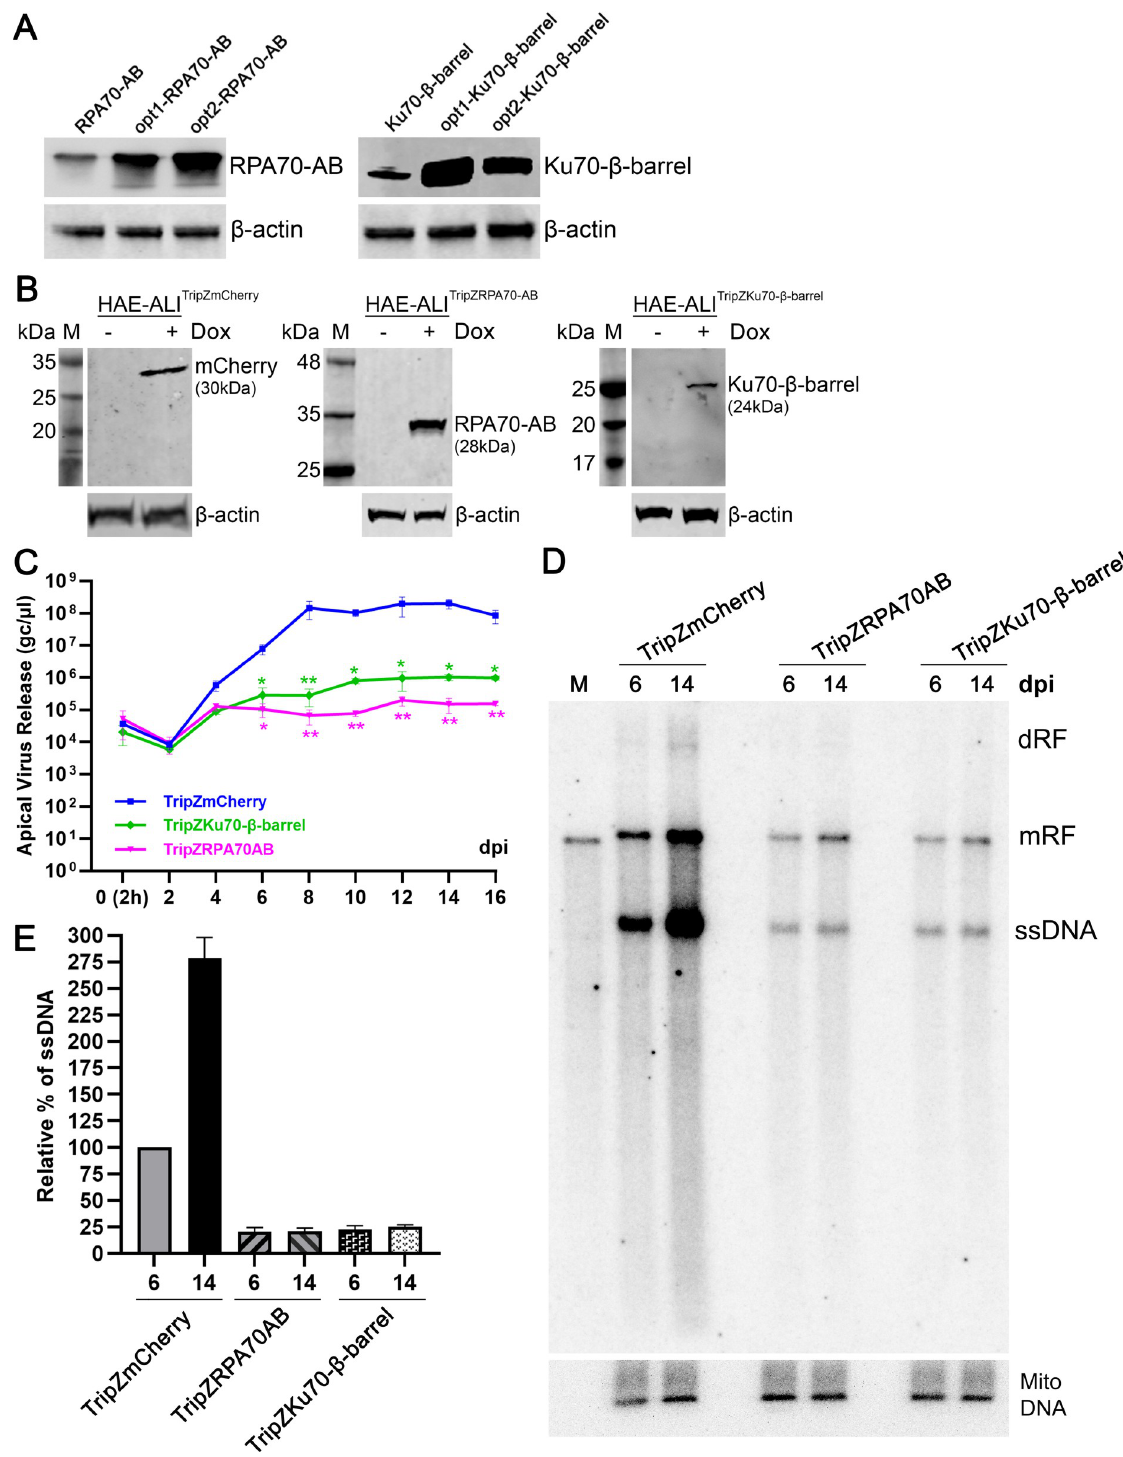
Fig 12. Overexpressions of the AB domain of RPA70 and the β -barrel domain of Ku70 significantly decrease HBoV1 replication in HAE-ALI. (A) Codon optimization of RPA70-AB and Ku70- β -barrel. HEK293 cells were transfected with plasmids expressing codons optimized RPA70-AB Strep-HA and Ku70- β -barrel Strep-HA ORFs, respectively. At 2 days post-transfection, the cells were collected and lysed for Western blotting using anti-Strep. β -actin was probed as a loading control. (B) Induction of expression of mCherry, RPA70-AB, and Ku70- β -barrel domains in HAE-ALI. HAE-ALI cultures were derived from the airway epithelial cells transduced with lentivirus